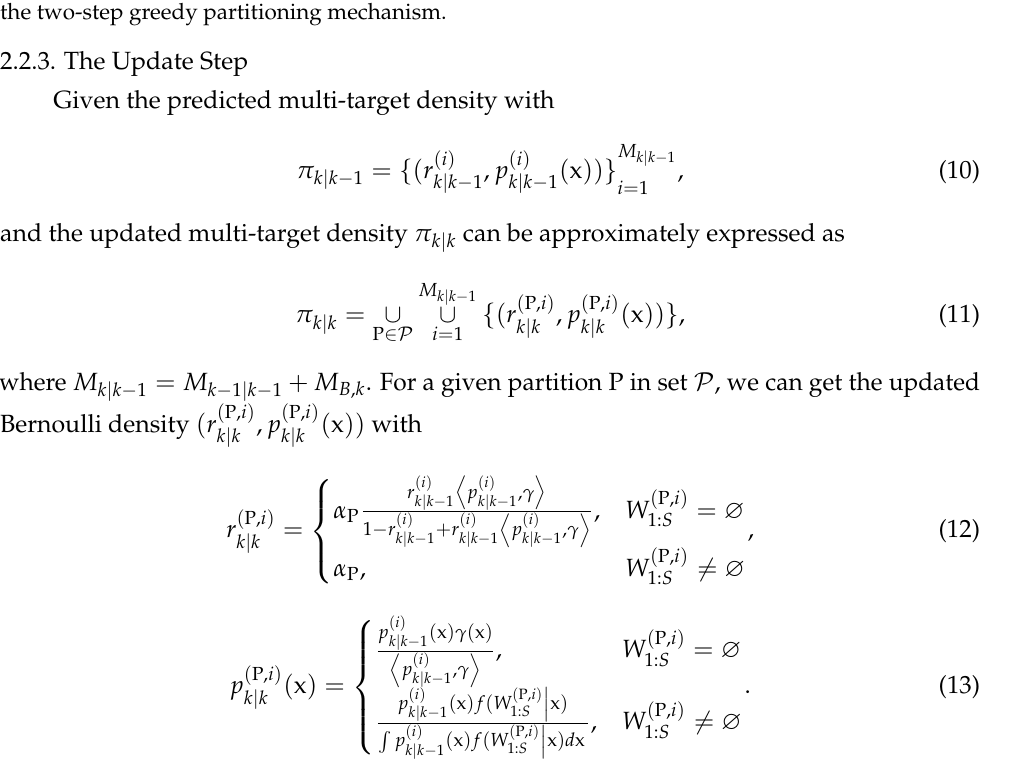
( P, i ) represent different results from the first step of 1:4